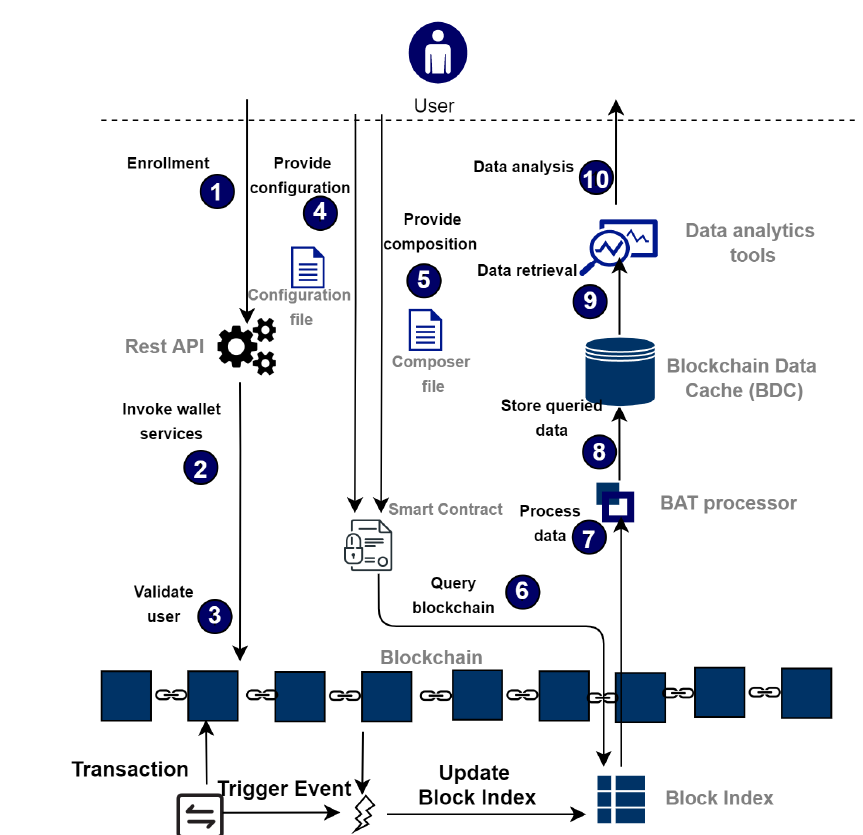
Figure 5. Overall execution procedure of BAT integrated with the blockchain.